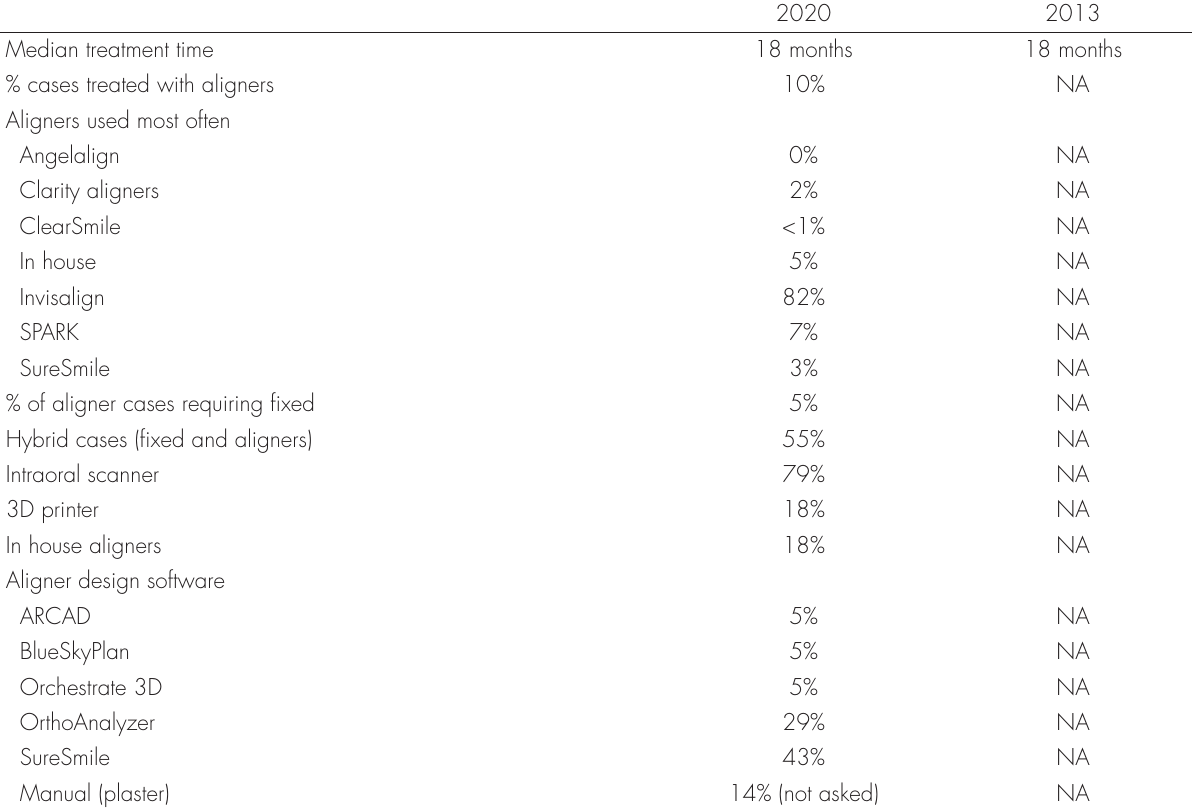
Table V. Aligner treatment.